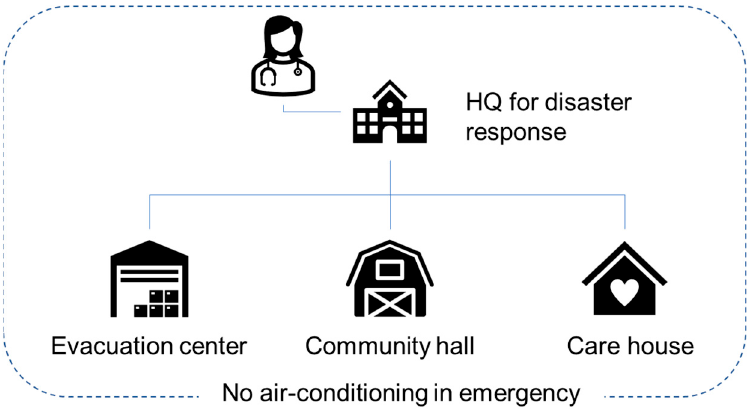
Figure 1. Standard resilience facilities with their energy source requirement and estimated energy consumption during disaster response.